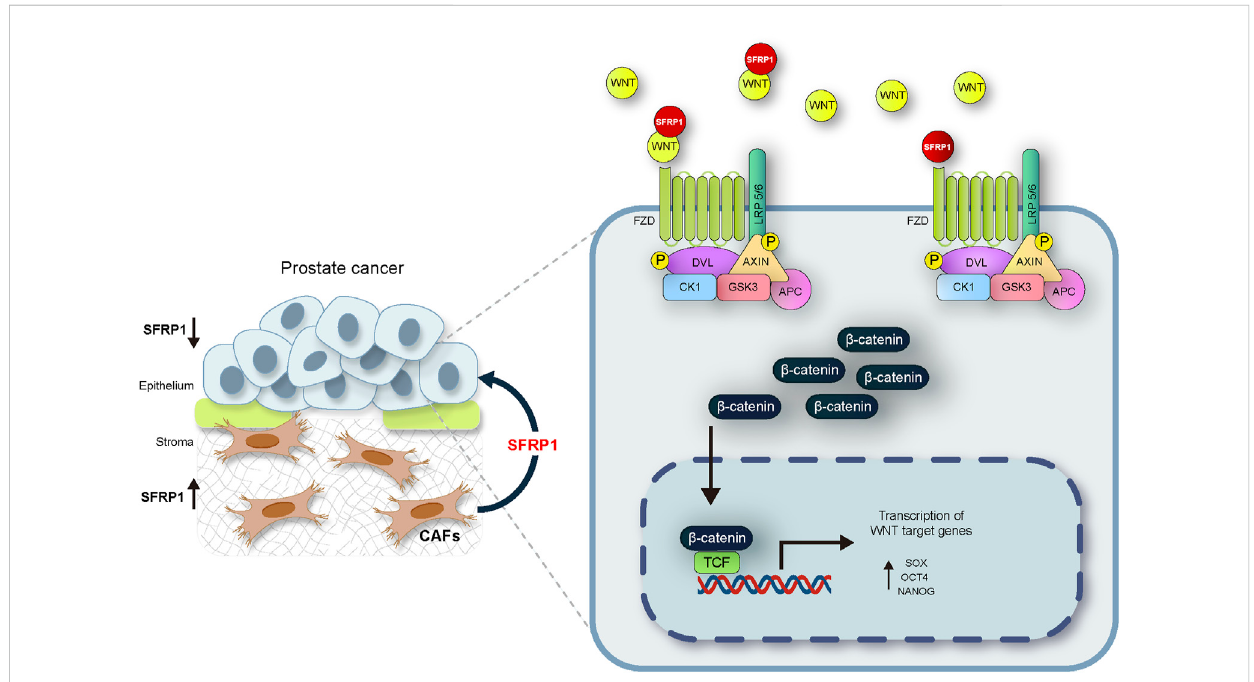
FIGURE 7 The suggested mechanism by which the loss of SFRP1 expression in epithelial cells linked with the stromal SFRP1 signalling axis promotes the stemness of prostate cancer cells and reduces their sensitivity to bicalutamide. SFRP1 induces higher SOX2, OCT4, and NANOG expression levels, all within the context of WNT/ β -catenin pathway